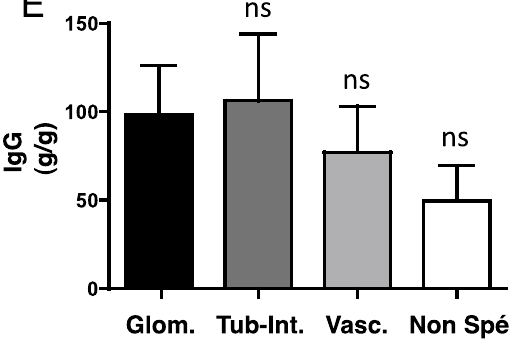
Figure 2. Expression patterns of proteinuria. A , B . Best-fit slope of the linear regression between RBP and b 2MG (A) and RBP and Alb (B). C , D , E . Histogram showing Alb (A), RBP (B), and IgG (C) values according to the type of kidney disease. Protein concentrations are expressed as the mean 6 sem. **p , 0.01, ***p , 0.001 compared to glomerular disease using Student’s T test; the Mann-Whitney test was used for the glomerular vs. comparison with non-specific lesions. Glom: glomerular diseases; Tub-Int: tubular and/or interstitial diseases; Vasc: vascular diseases; Non-spe: non- specific.